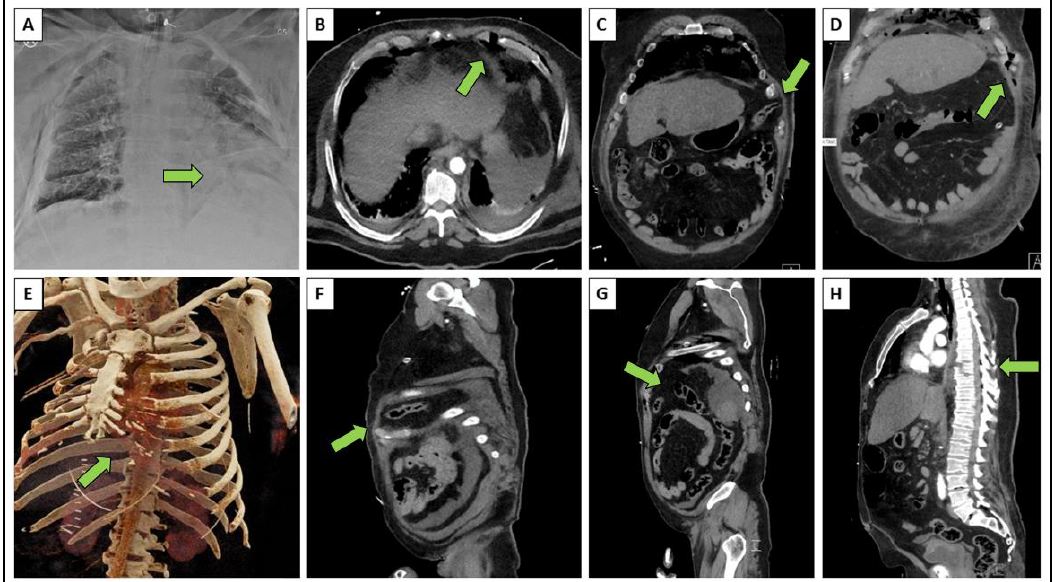
Figure 1. Initial X-ray and whole body CT scan: ( A ) anterior-posterior view, ( B ) axial CT slice, ( C , D ) coronar CT slices, ( E ) 3D-CT reconstruction, ( F – H ) sagittal CT slices. The respective injuries are marked with arrows. A 65-year-old male suffered from a fall from a height of six meters. Initial X-ray of the chest shows left-sided high-riding diaphragm (Figure 1A). CT scan proves anterior cartilage fracture (Figure 1B), traumatic intercostal hernia within the widened 7th intercostal space (Figure 1C – F), disruption of the diaphragm creating a two-cavity injury (Figure 1G), and distraction fracture of the 7th thoracic vertebra (Figure 1H). The diagnostics showed additional ipsilateral serial rib fractures posterolateral with involvement of the ribs VI–X. This results in a combined thoracovertebral injury entity, consisting of a disruption of the thoracic spine and the costal arch monolaterally torn in the anterior area with anterior fractures of the ribs VII and VIII at their cartilage conjunction, in addition to their posterolateral fractures. The sternum, the mediastinal organs, the center of the diaphragm, and the great vessels did not show any injuries in this